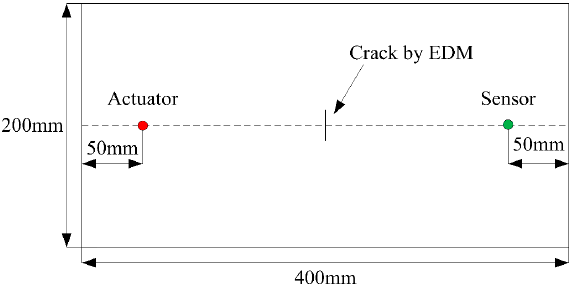
Figure 9. The geometry of the testing specimen and the layout of the piezoelectric (PZT) sensors. EDM = electric discharge machining. Table 1. Mechanical properties of the testing specimen.